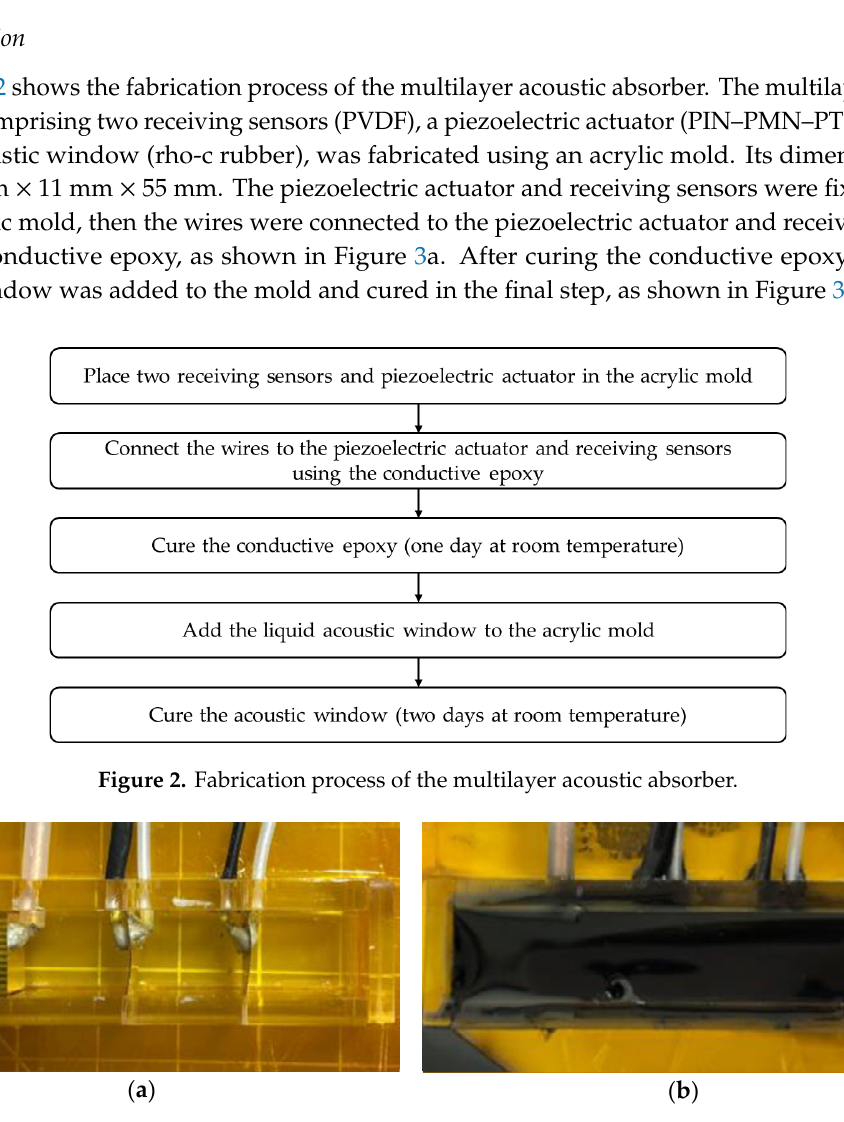
Table 1. Properties of the components of the proposed multilayer sensor.